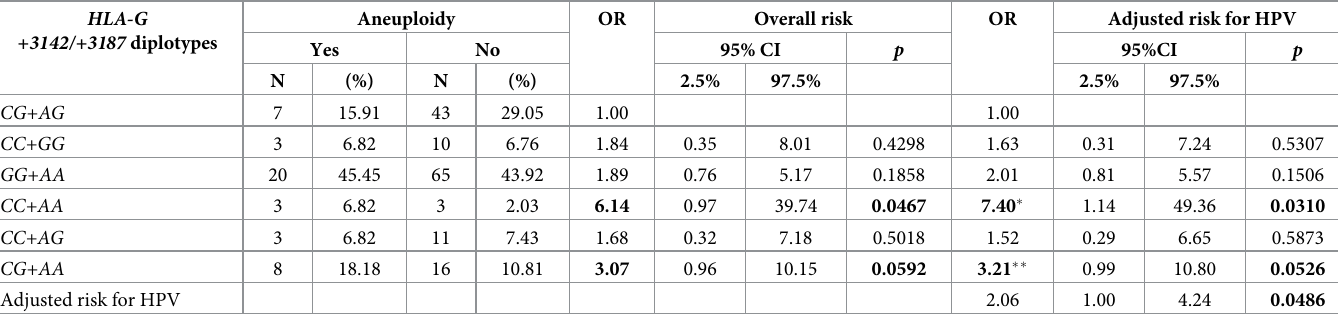
Table 4. Linear regression between the HLA-G +3142/+3187 diplotypes and presence of aneuploidy in cervical cells from HIV-infected women. Aneuploidy HLA-G +3142/+3187 diplotypes